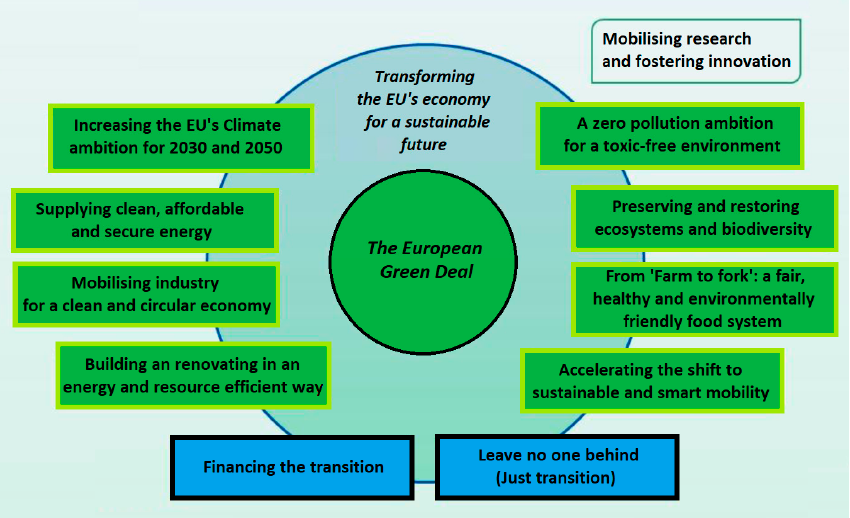
Figure 4. The European Green Deal, source: own study based on